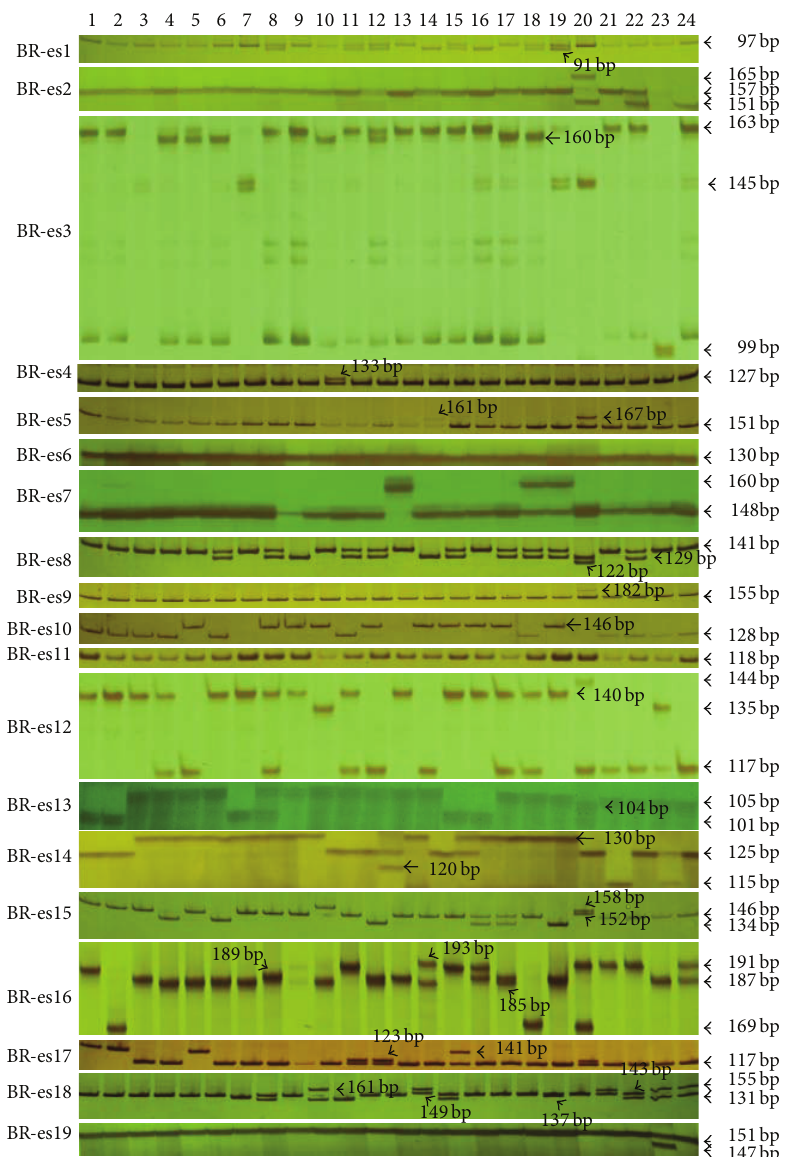
Figure 5: PCR products amplified by nineteen effective EST-SSR primer pairs in twenty-four cultivars of Chinese cabbage. The order of DNA samples from lane 1 to lane 24 within each primer pair image panel is 682, GuangDongZao, ZaoHuangBai, Z61-8, FuShanBaoTou, Li-3, 212-7, TianJinQingMaYe, KuaiCai number 6-5, JinHuangXiaoBaiCai, SiJiXiaoBaiCai, SiJiHuangYangXiaoBaiCai, PinZao number 1, HanYuTeXuanHuangXin, QuanNengSiJiKuaiCai, JingYouXiaoBaiCaiKuaiCai, GaoLiWaWaCai, KeYiXiaWaWa, JinNuoChunQiuWaWaCai, SiJiLvGanXiaoKuCai, YouLv157, ShuYaoYouCai, DeGaoYouLiangQingGengCai, and QingXiuF1QingGengCai. PCR products amplified by BR-es2, BR-es3, BR-es6, BR-es7, BR-es12, BR-es13, BR-es14, BR-es16, and BR-es19 primer pairs were separated on 6% denaturing polyacrylamide gels, while those amplified by BR-es1, BR-es4, BR-es5, BR-es8, BR-es9, BR-es10, BR-es11, BR-es15, BR-es17, and BR-es18 primer pairs were separated on 12% nondenaturing polyacrylamide